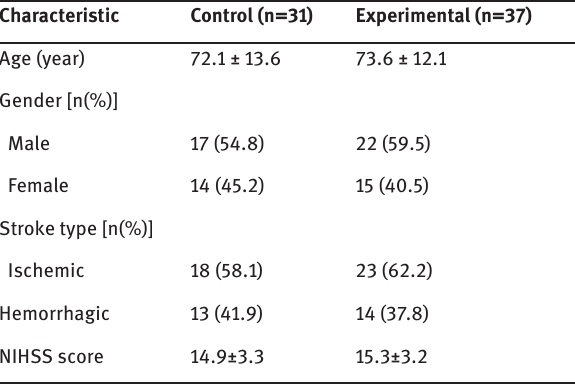
Table 1: The general characteristics of patients in the two